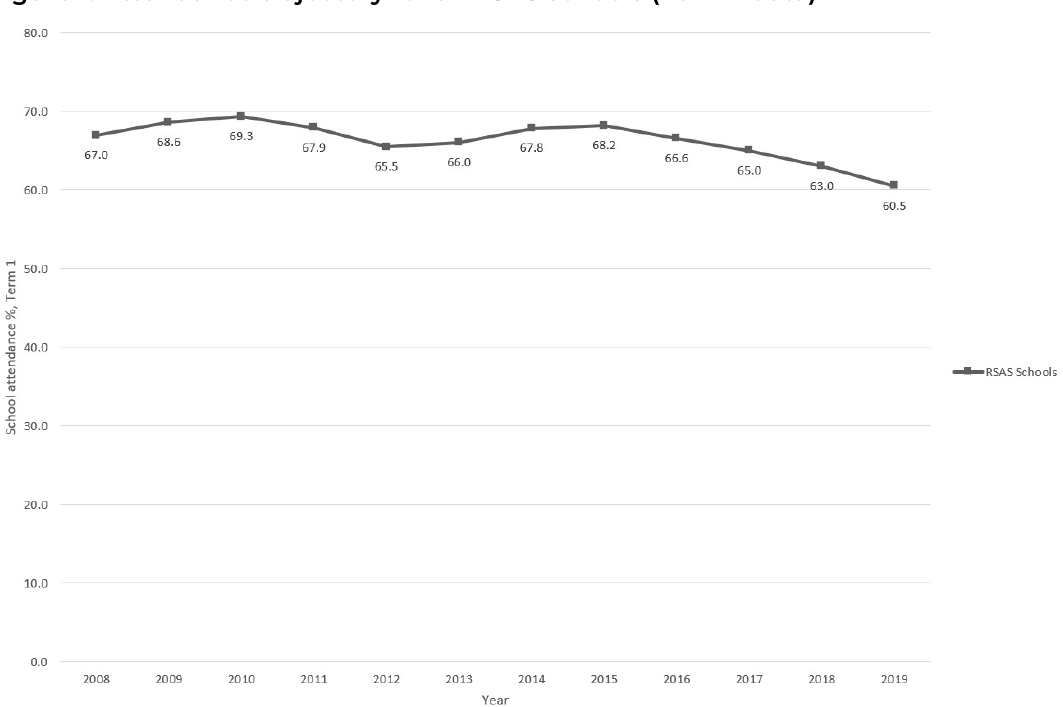
Figure 1: Attendance trajectory for all RSAS schools (Term 1 data)